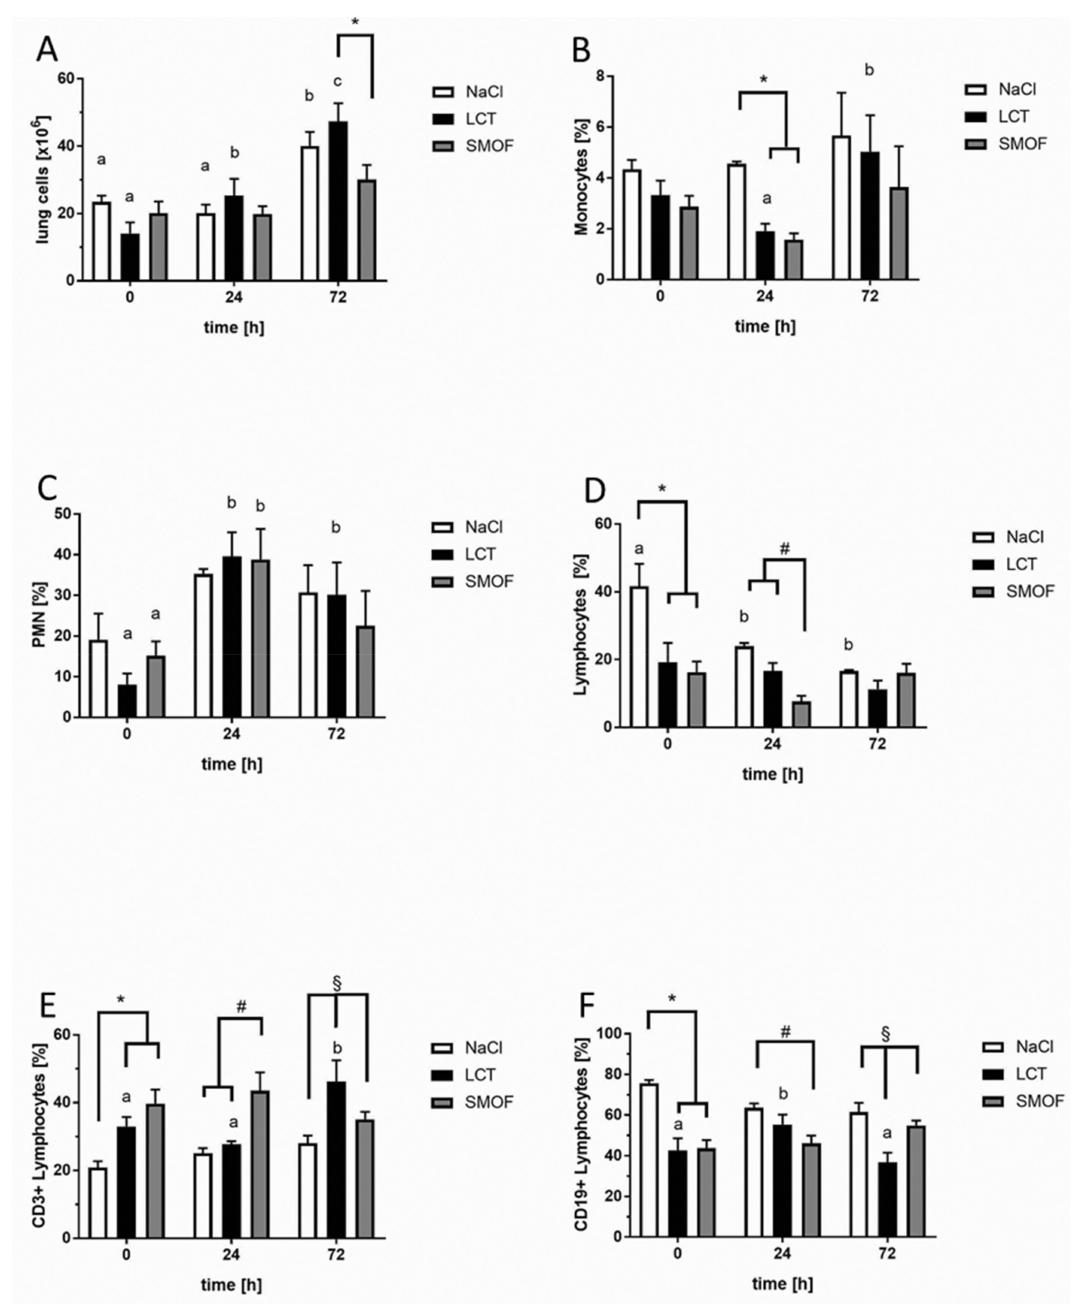
Figure 5. E ff ect of lipid emulsions on lung-tissue leukocytes in LPS-induced acute respiratory distress syndrome. ( A ): Interstitial cells were significantly reduced 72 h after induction of ARDS in animals receiving SMOF compared to the LCT group (*, p < 0.01). ( B ): Analysis of the leukocyte sub-populations revealed a significant decline in the percentage of monocytes in the LCT and SMOF groups compared to the NaCl group 24 h after ARDS induction (*, p < 0.01). ( C ): For PMNs, no significant di ff erences among the di ff erent infusion groups were detected. ( D ): For interstitial lymphocytes, a